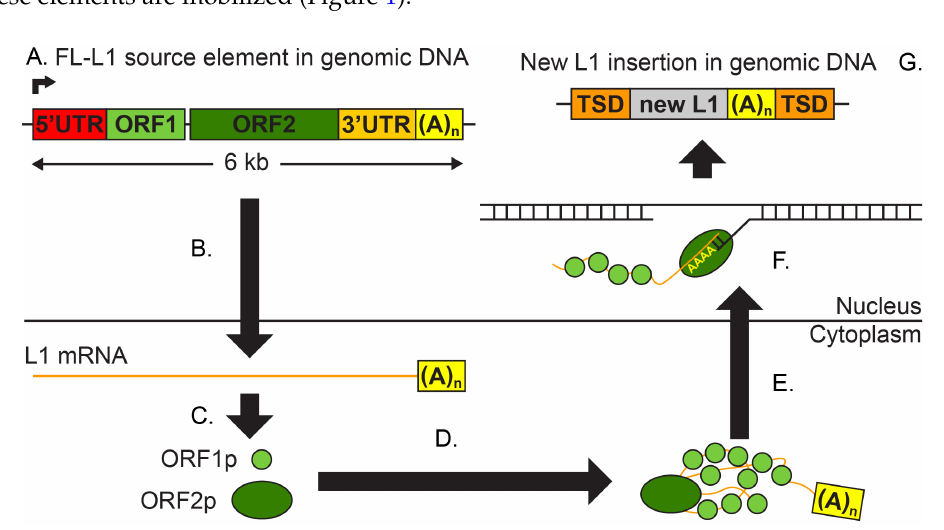
Figure 1. Mobilization of L1s. New L1 insertions are generated via the five step process depicted here. This process begins with a full-length (FL)-L1 source element in the genomic DNA ( A ; colored bar; L1 features are not to scale). This element is transcribed ( B ) and the resulting mRNA (orange) is exported into the cytoplasm. This mRNA is translated ( C ) into the open reading frame (ORF)1p (light green) and ORF2p (dark green) proteins, which bind the L1 mRNA to form a ribonucleoprotein complex ( D ). This complex is imported ( E ) into the nucleus. Finally, the new L1 insertion is generated by target-primed reverse transcription ( F ). The result of this mobilization process is another copy of L1 (grey) located somewhere in the genome, flanked by target site duplications (TSDs; orange) and with a poly(A) tail (yellow) ( G ). UTR; untranslated